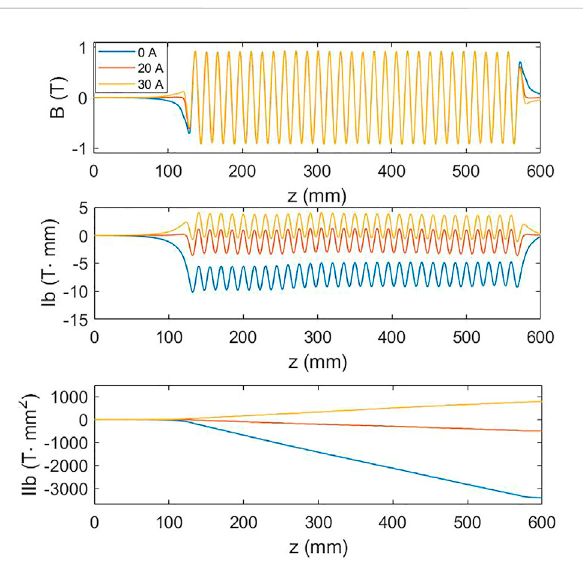
FIGURE 9 Magnetic fi eld curves and the corresponding fi rst and second fi eldintegralsat400Amaincurrentwith0A,20A,and30Acorrection currents,